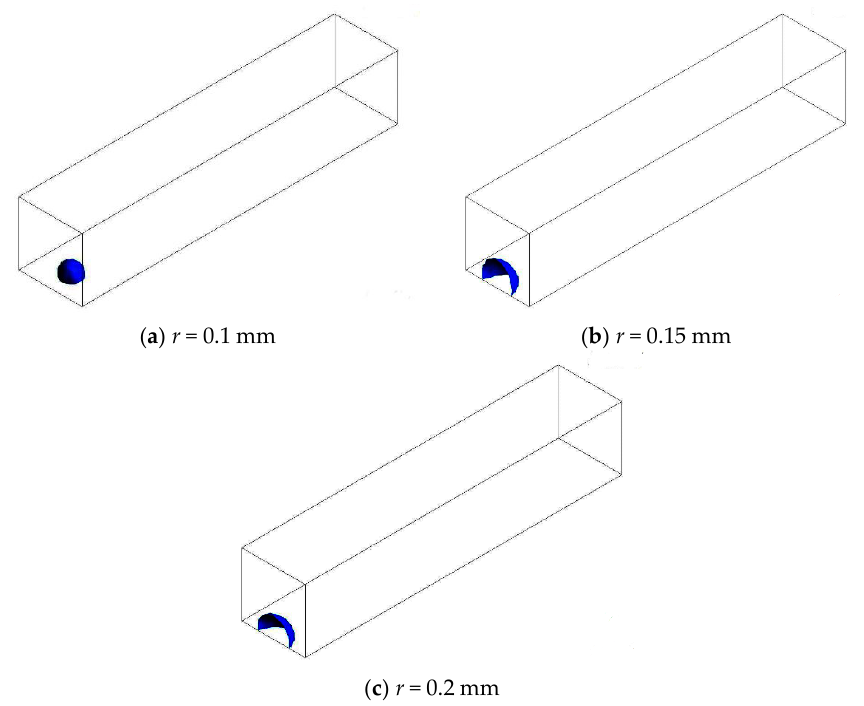
Figure 7. Water droplet behavior at different initial radius ( t = 1 ms & all the surfaces contact angles are 135°).